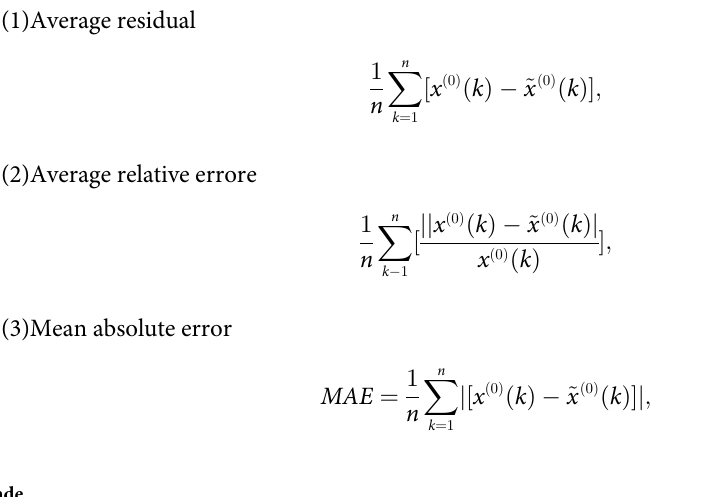
Table 1. The reference table of precision check grade.